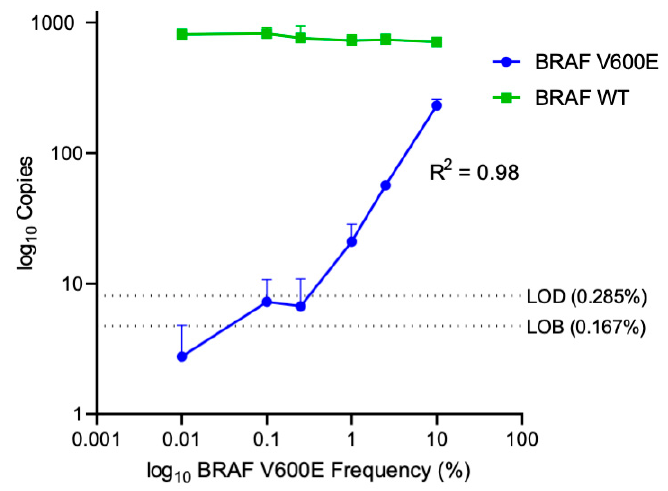
Figure 3. BRAF V600E serial dilutions in a constant background of BRAF WT. Log of absolute copy number of BRAF V600E (blue) and BRAF WT (green) are plotted against log mutant frequency. Data points are plotted as mean +/ − SD. Serial dilutions of Yumel 0106 gDNA were prepared in a constant background of HBMVEC gDNA from 10% to 0% mutant allele frequency to determine the limit of detection and limit of blank of the ddPCR assay. The limit of blank (LOB), the highest apparent BRAF V600E concentration expected to be found in a sample without mutant input, and limit of detection (LOD), the concentration of BRAF V600E that can be reliably distinguished from background, are denoted by the dotted lines.